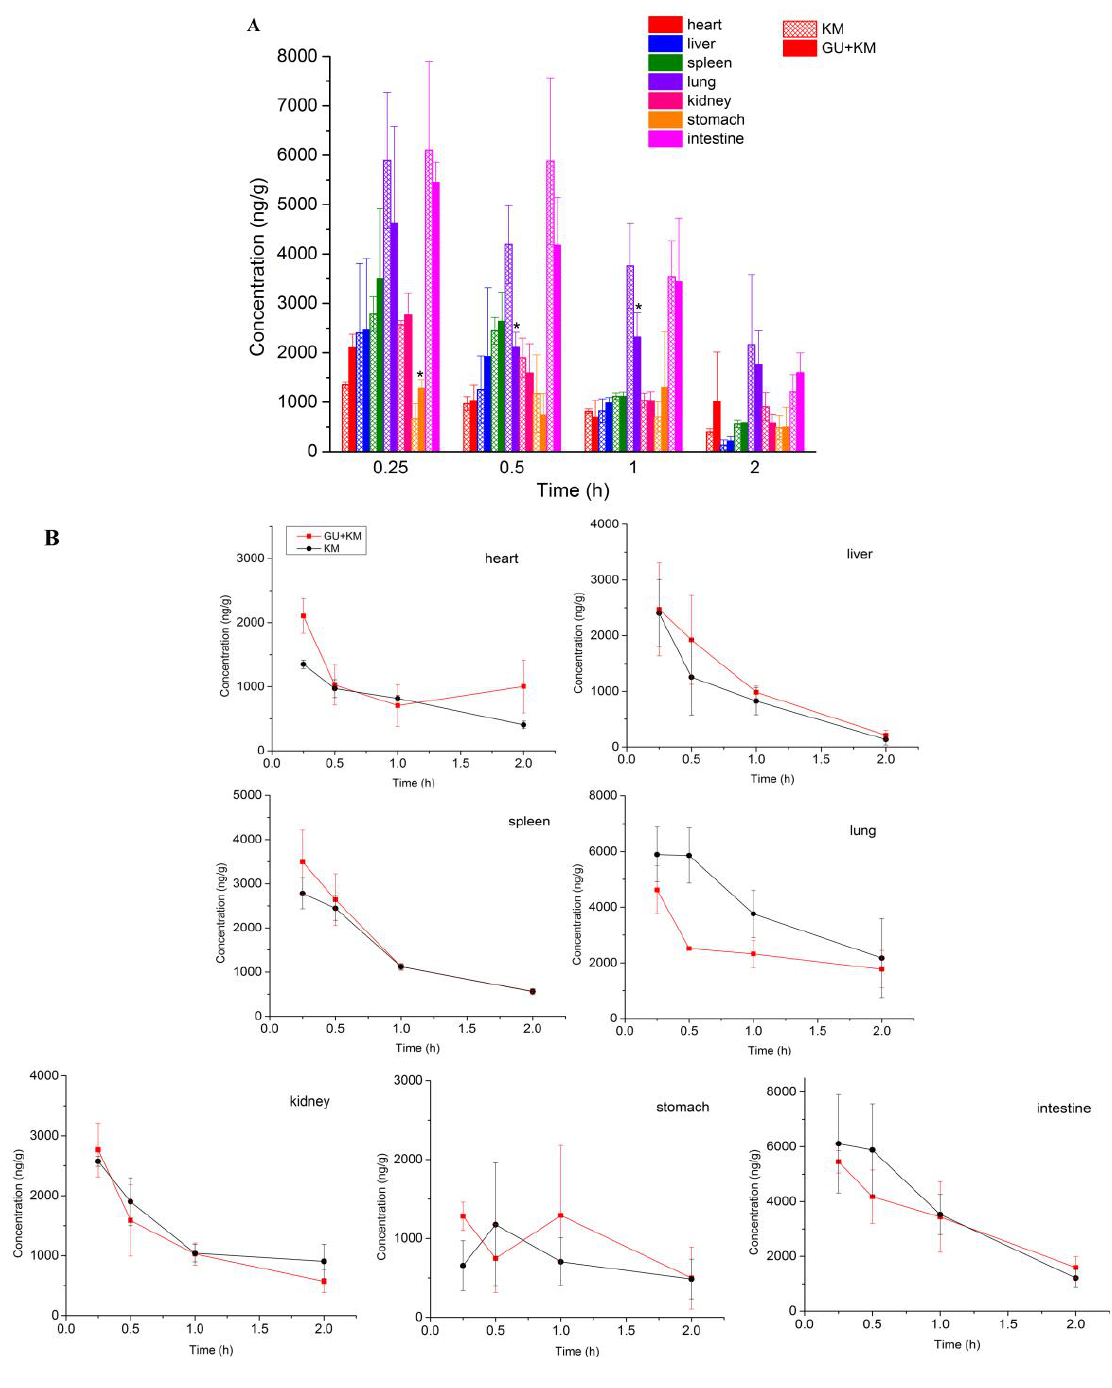
Figure 4. Mean ± SD (n = 6) concentration-time profiles ( A ) and distribution decline trend ( B ) of koumine in tissues following intravenous administration of 10 mg/kg KM that received or did not receive GU (3 g/Kg, once daily for 14 days, * p < 0.05, compared with the KM group).